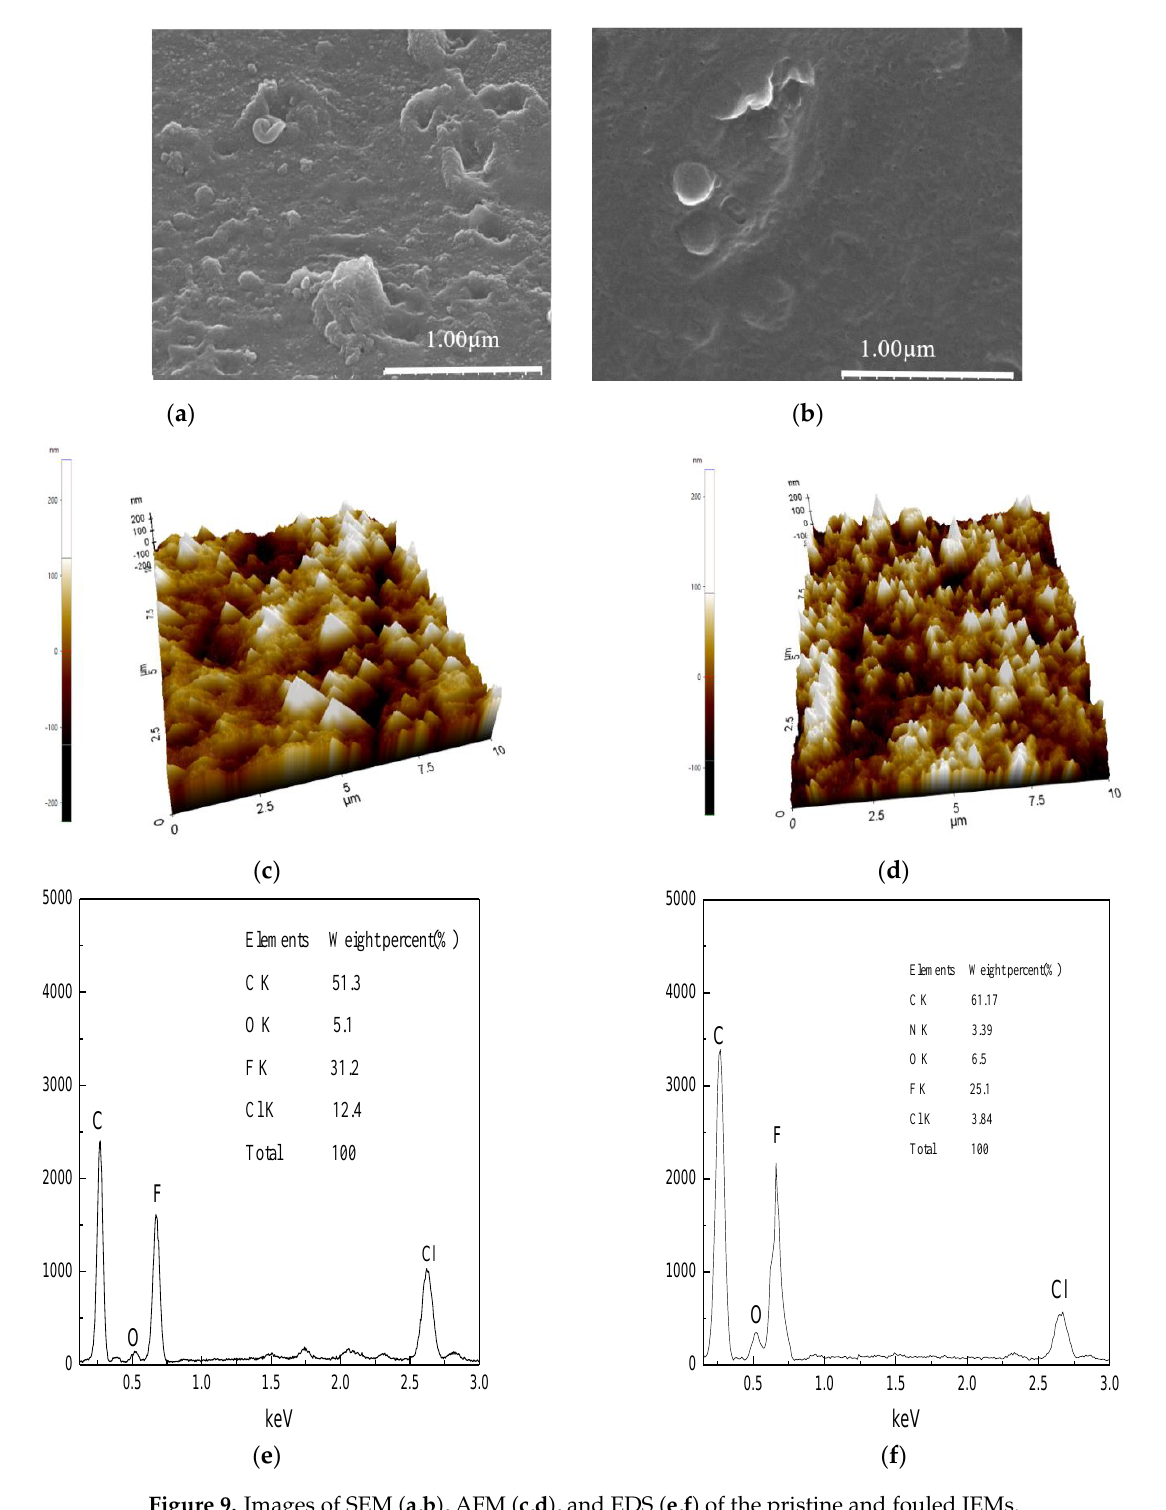
Figure 9. Images of SEM ( a , b ), AFM ( c , d ), and EDS ( e , f ) of the pristine and fouled IEMs